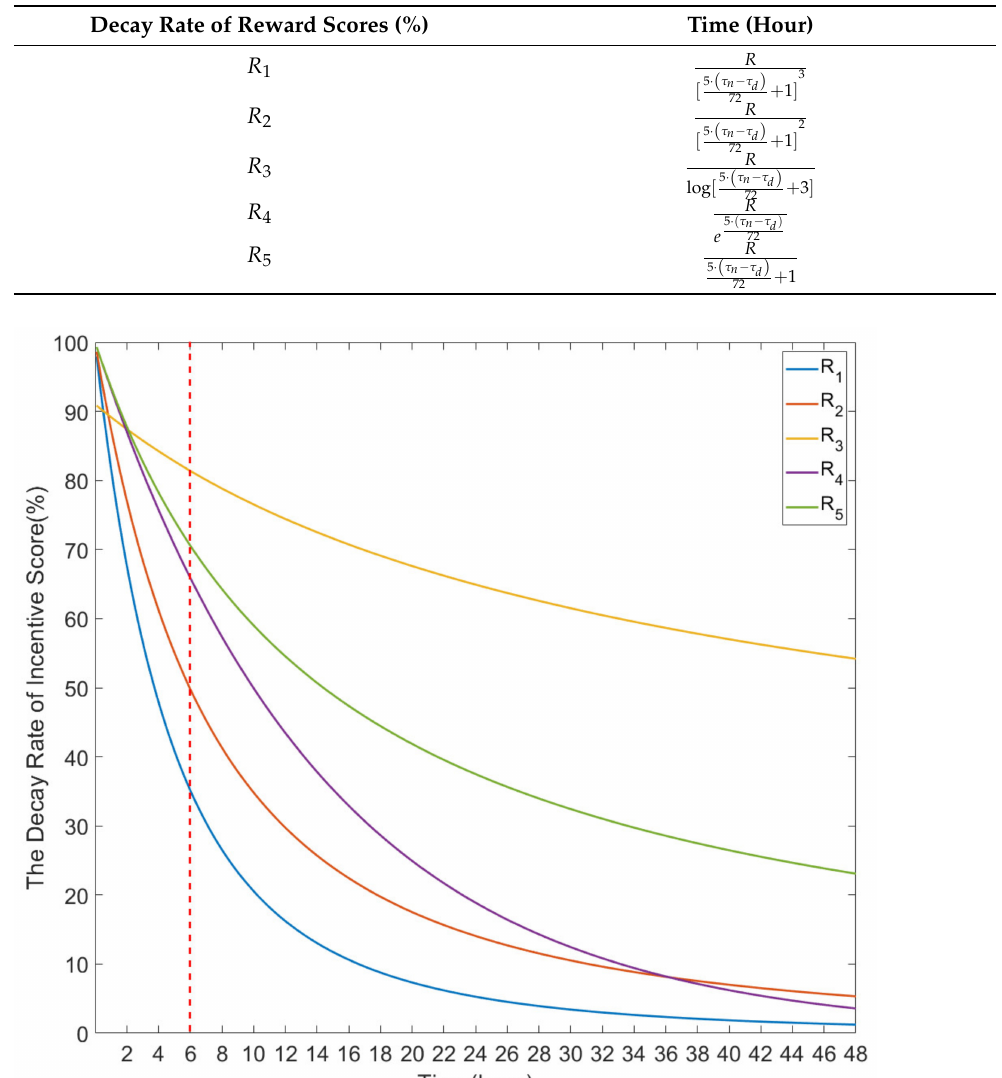
Table 2. Incentive score negative attenuation formula.